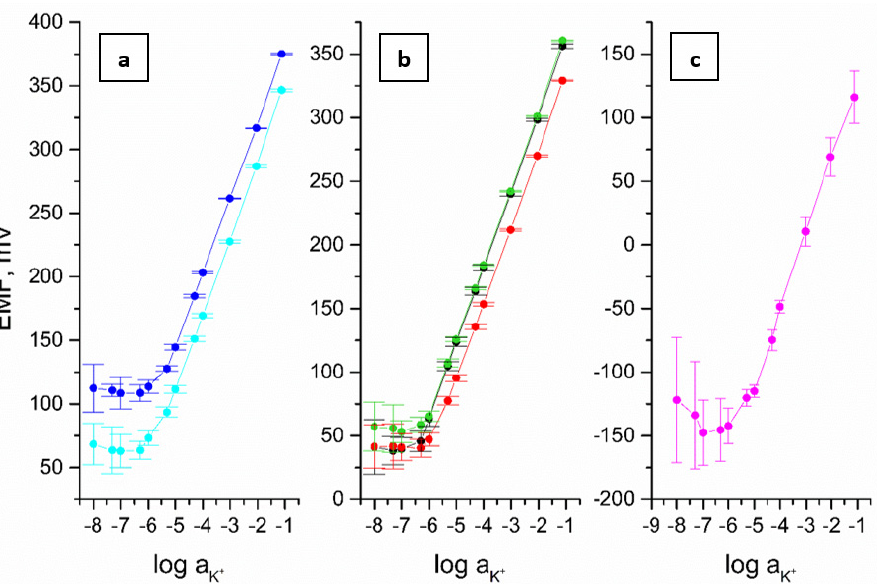
Figure 3. The potentiometric response recorded in KCl solutions for the following electrodes ( a ):